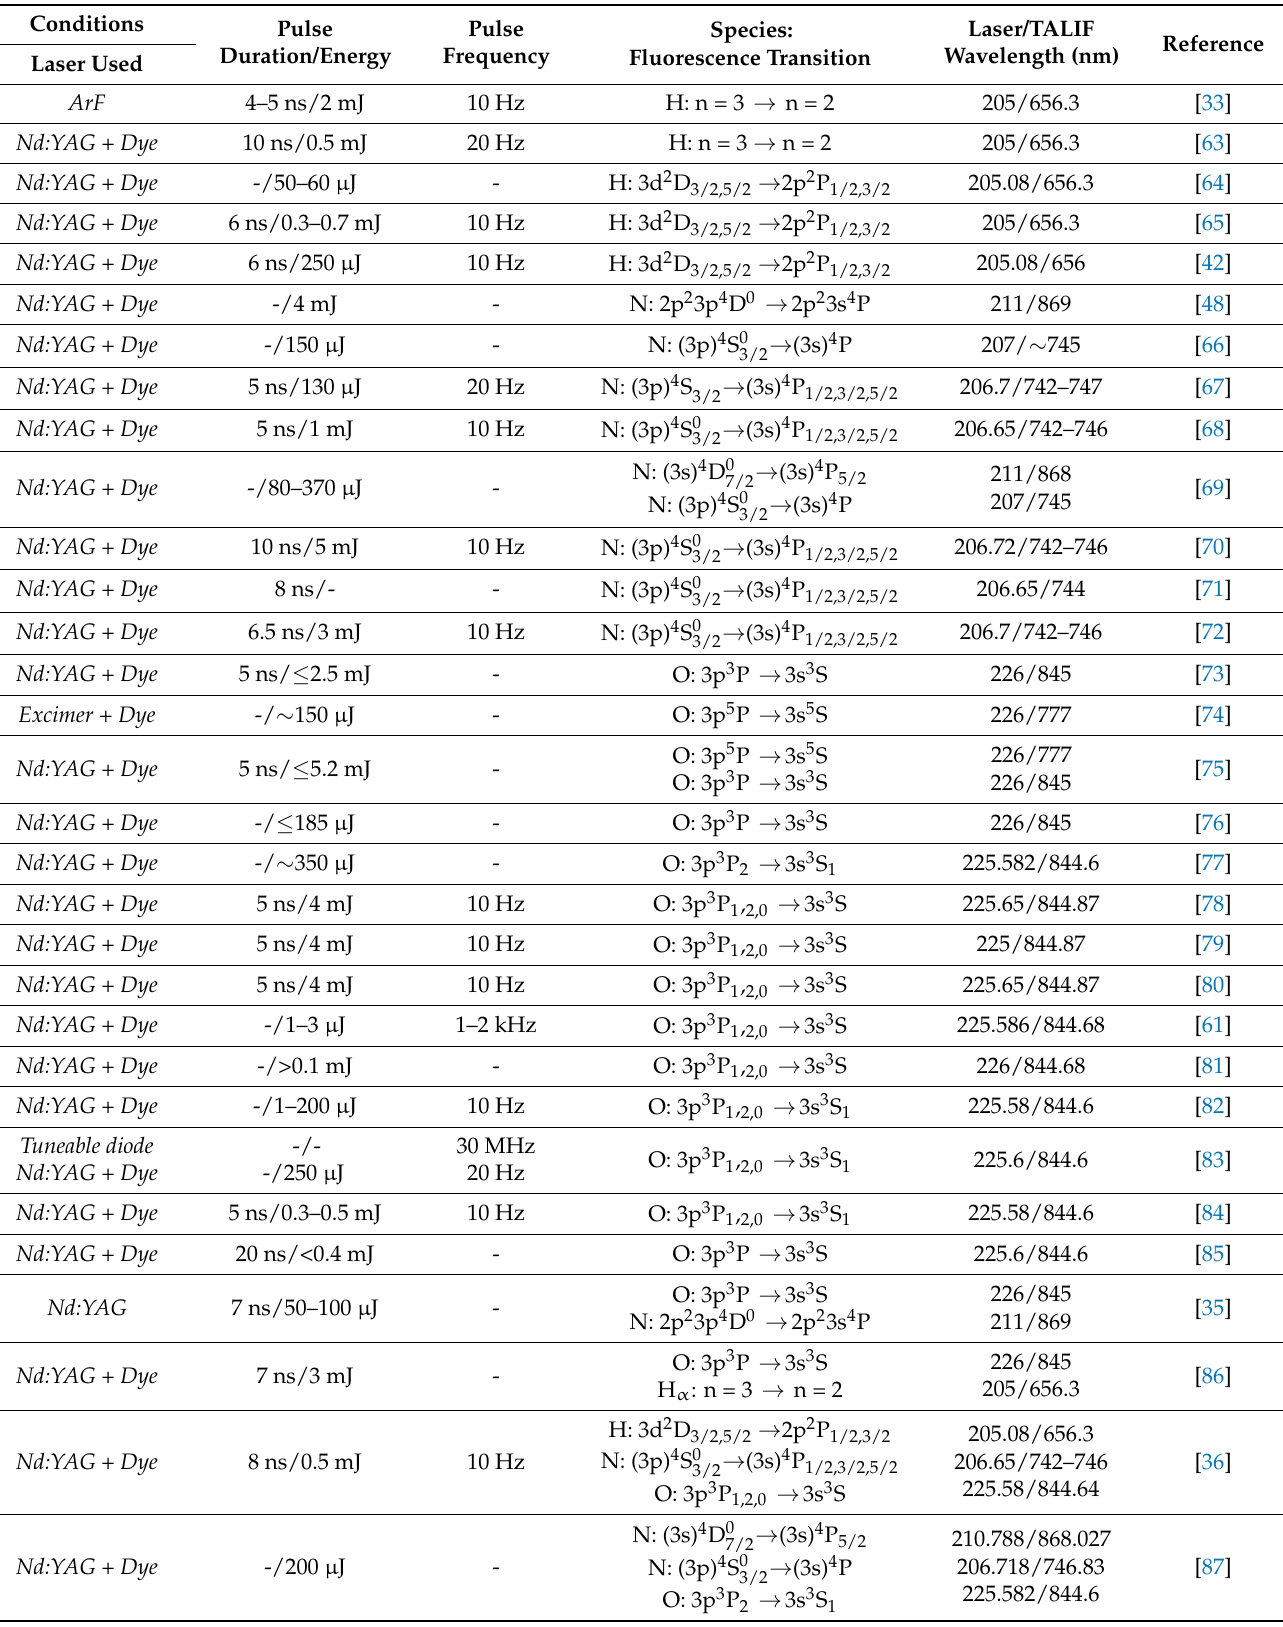
Table 1. Excitation schemes and laser characteristics used in different ns–TALIF studies to probe the most common atomic species (H, N and O) in plasmas and